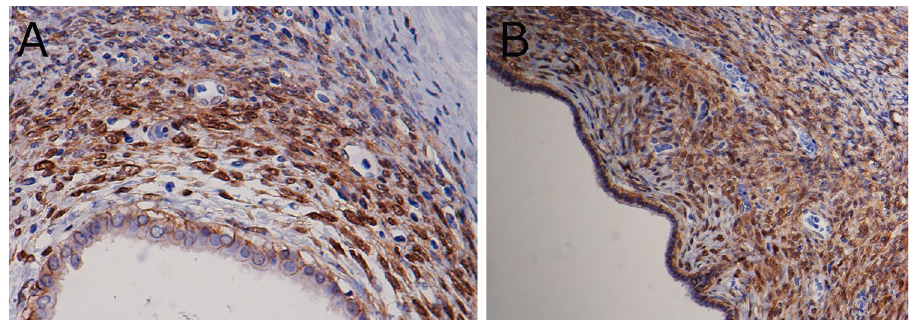
Figure 3. Nuclear accumulation of β-catenin in ovarian-like stroma (OLS). For both the intralobular OLS ( A ) and OLS at the cyst wall ( B ), nuclear accumulation of β-catenin was observed. [ A , B Immunohistochemistry for β-catenin].